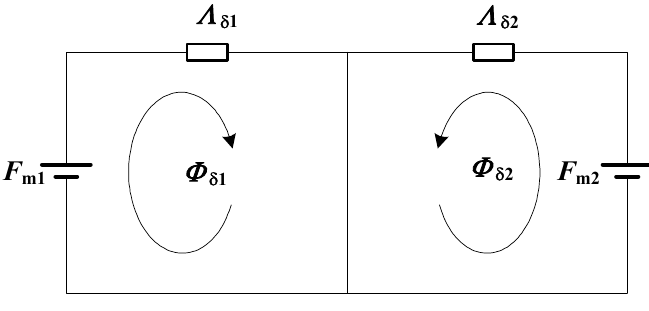
Figure 4. Simplified magnetic